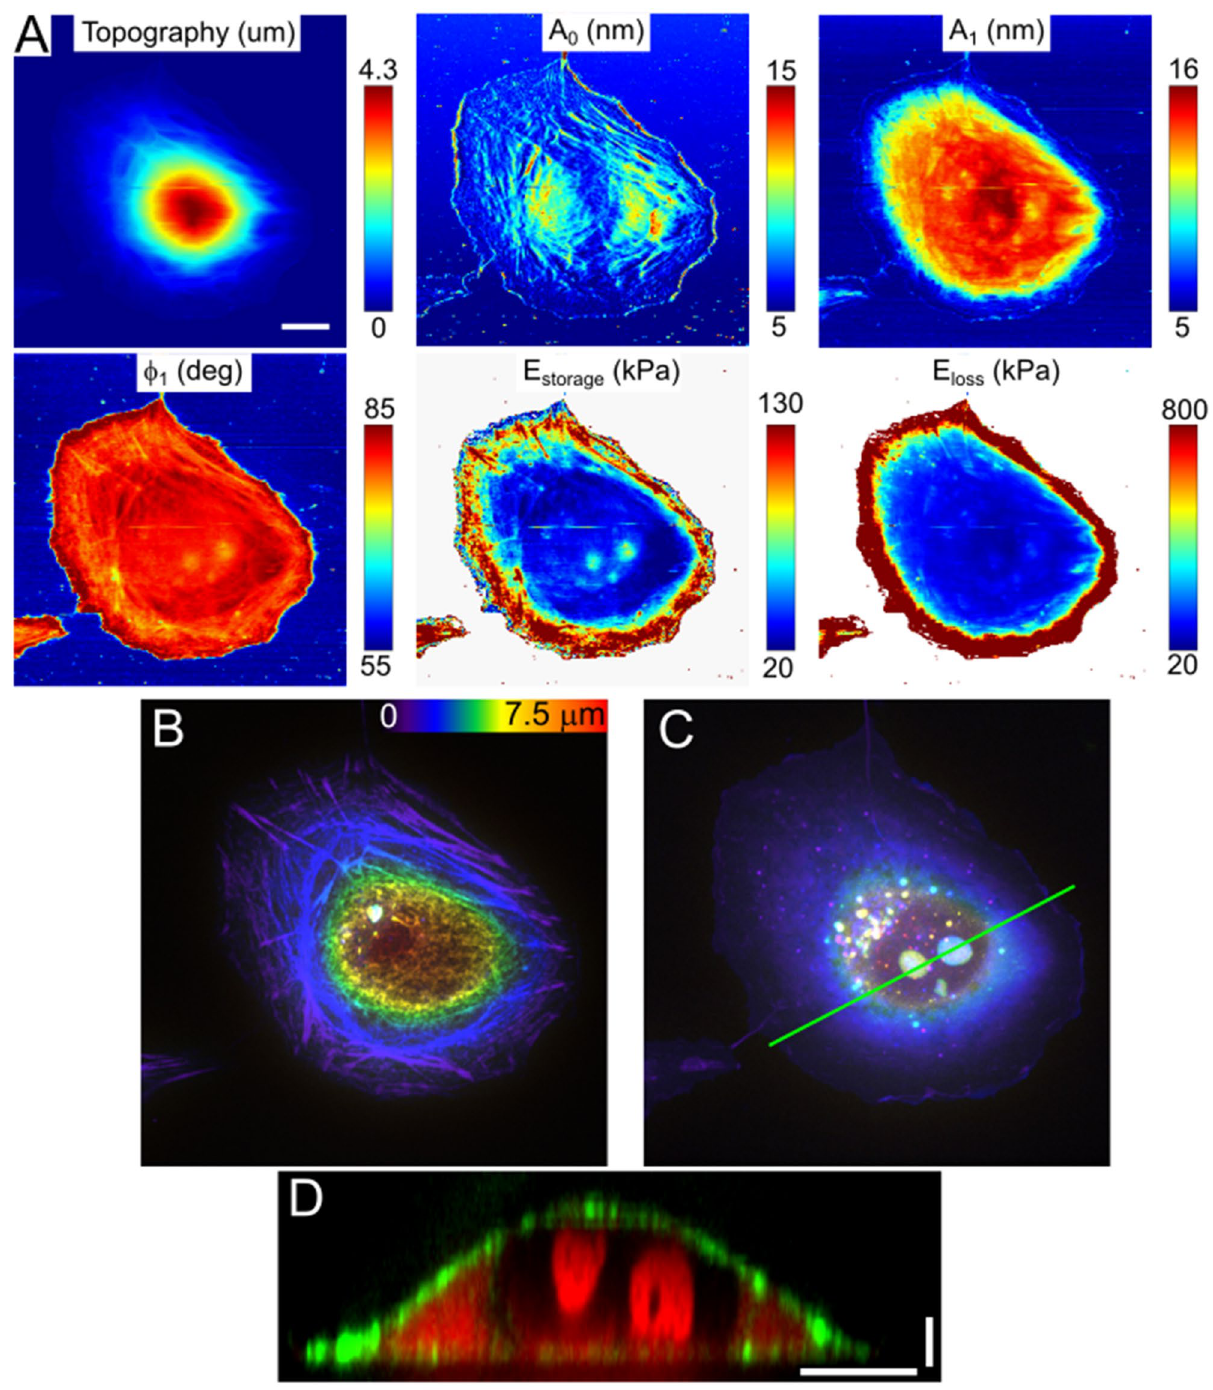
Figure 4. MDA-MB-231 breast cancer cell, AFM observables and nanomechanical maps ( A ) and SDCM color- coded height images ( B , C ). Some peripheral actin stress fibers and nucleoli could be detected in the amplitude and phase images, and in the E storage map. Only the actin fibers, but not nucleoli, are presented in topography and deflection images. ( B ) Corresponding images of the actin cytoskeleton (SiR-actin staining) and nucleoli (SYTO85 staining), color-coded Z-stacks. ( D ) Vertical cross-section along the marked line shows the size and depth of the nucleoli (red) and cell shape (F-actin, green). Scale bars are 10 μm in the horizontal direction and 2 μm in the vertical